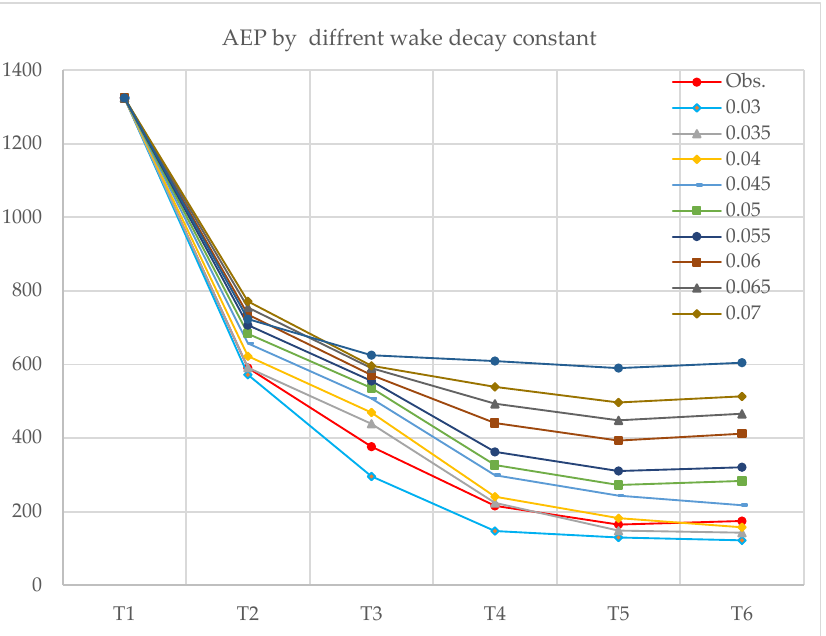
Figure 6. AEP by different wake decay constant when wind direction is 17-degree.